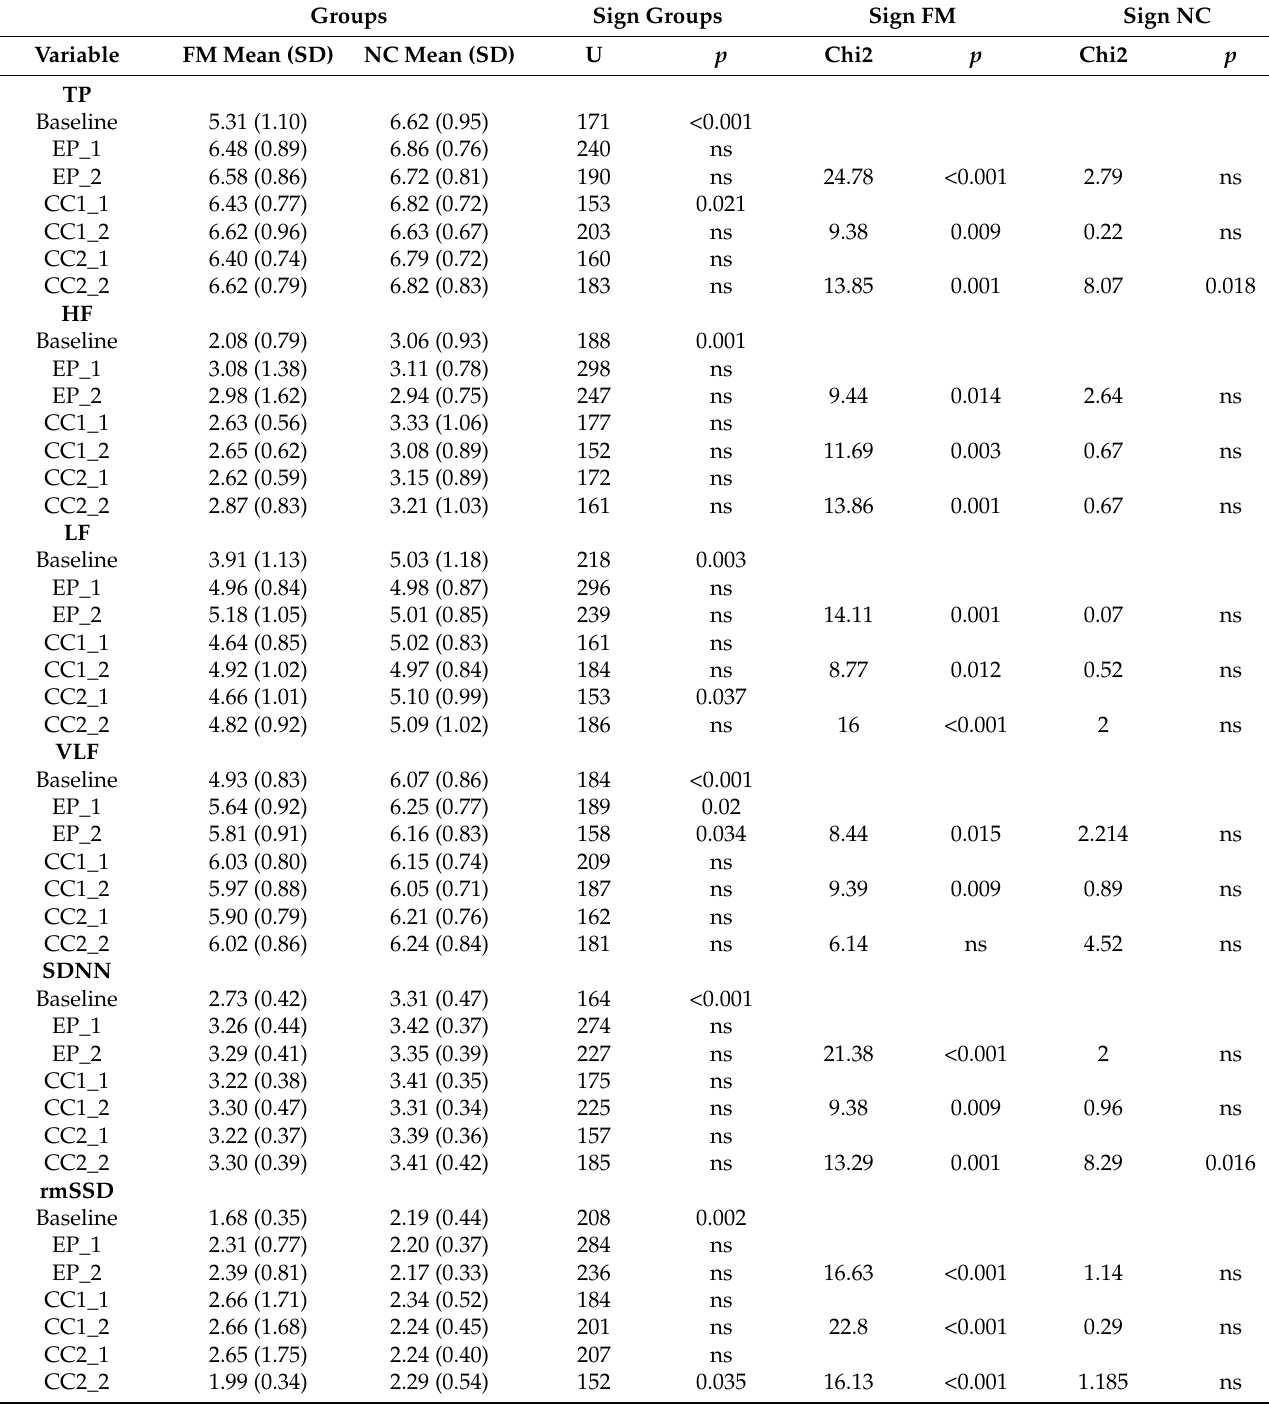
Table 1. Suppl. natural log mean and SD’s values of different HRV variables in FM patients and NC, differences between and within the groups during 5 min baseline, ≈ 8 min epoch 1 and